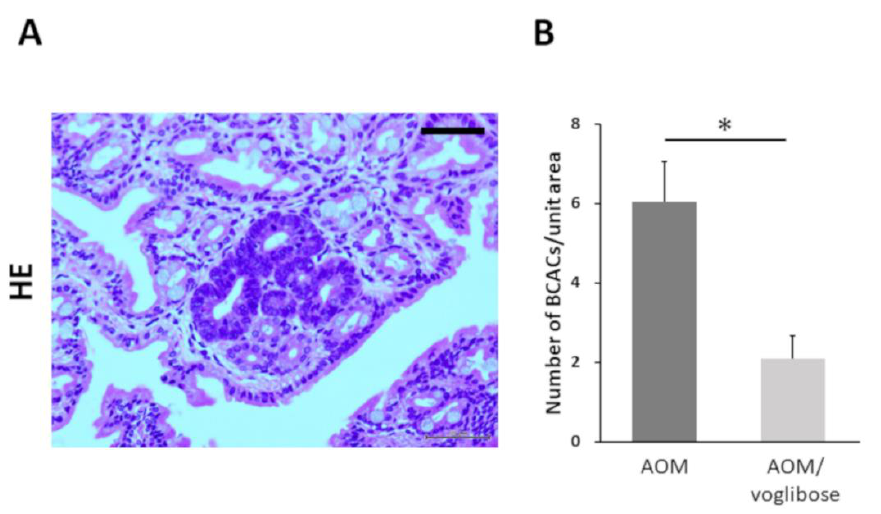
Figure 1. Development of BCAC in the colorectum of experimental mice. ( A ) Representative photographs of BCACs (HE staining) on the colonic mucosa of experimental mice treated with AOM. The atypical cryptal cells in BCAC have hyperchromatic nuclei and basophilic cytoplasm. The localization of accumulated β-catenin protein is apparent in the cytoplasm and nucleus of colonic atypical crypts. Scale bars, 100 µm. ( B ) Number of BCACs formed in the colorectum. The values are expressed as mean ± SE. Asterisk, statistical significance ( p < 0.05).